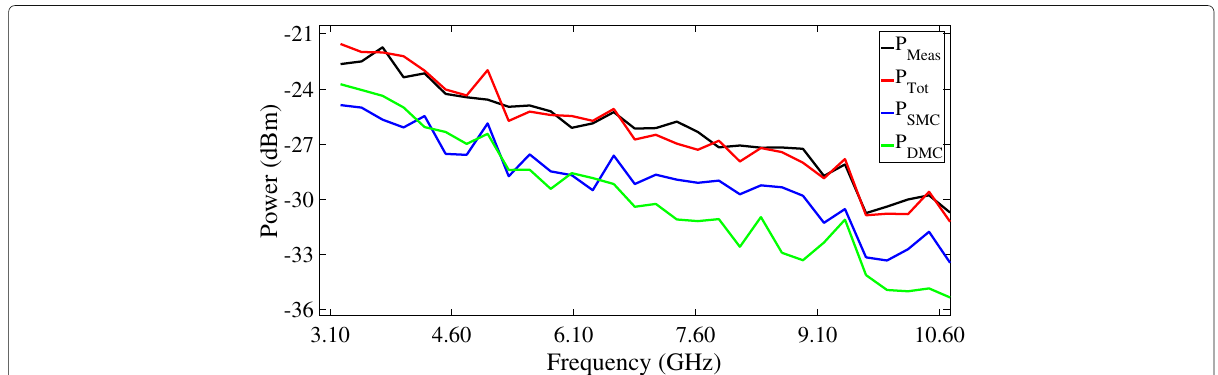
Fig. 16 Mean values of the measured powers in the radio channel as a function of UWB frequencies: LoS scenario